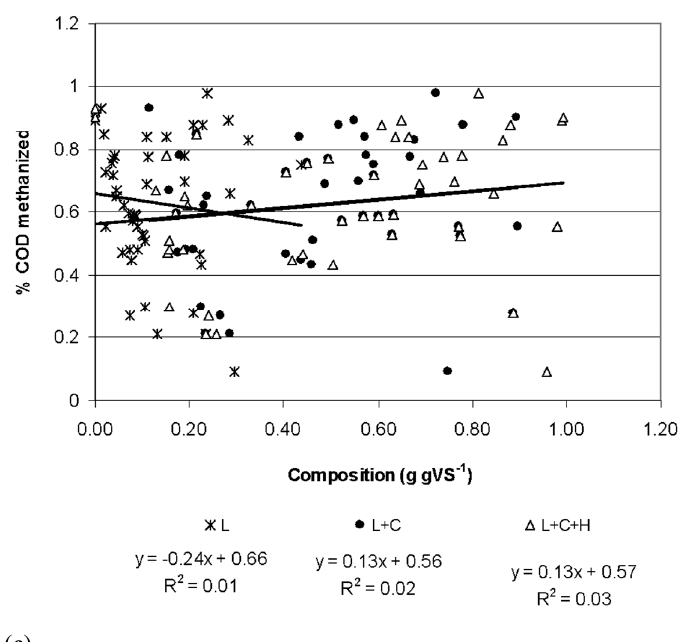
Figure 5. Relationship between anaerobic biodegradability (B o ) and substrate composition, using data from previous studies (from top to bottom: ( a ) data from References [22,24,26,28,29,50,54,56]; ( b ) data from three studies using van Soest method for substrate characterization [50,54,56] and this research; ( c ) data from studies using methods different from van Soest [22,24,26,28,29].